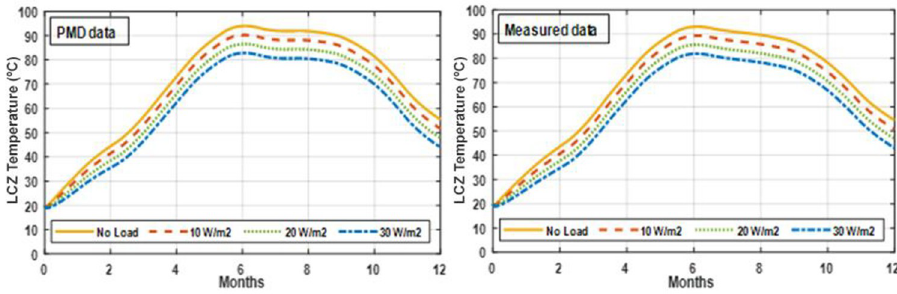
Fig 18. Heat extraction from the pond under PMD and measured climatic conditions of